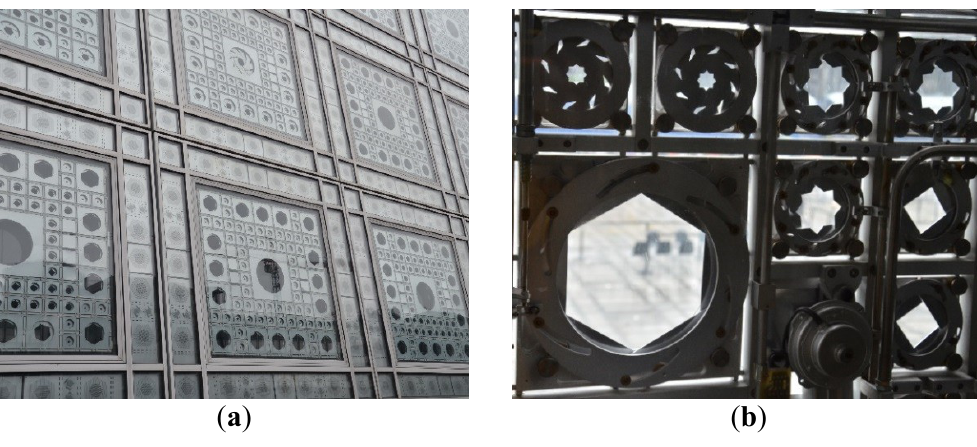
Figure 1. ( a ) This adaptive façade (Institut du Monde Arabe, Paris (France), 1987) provided an impetus for further development of dynamic building enclosures; ( b ) An array of shutters in the same façade shown in different stages of